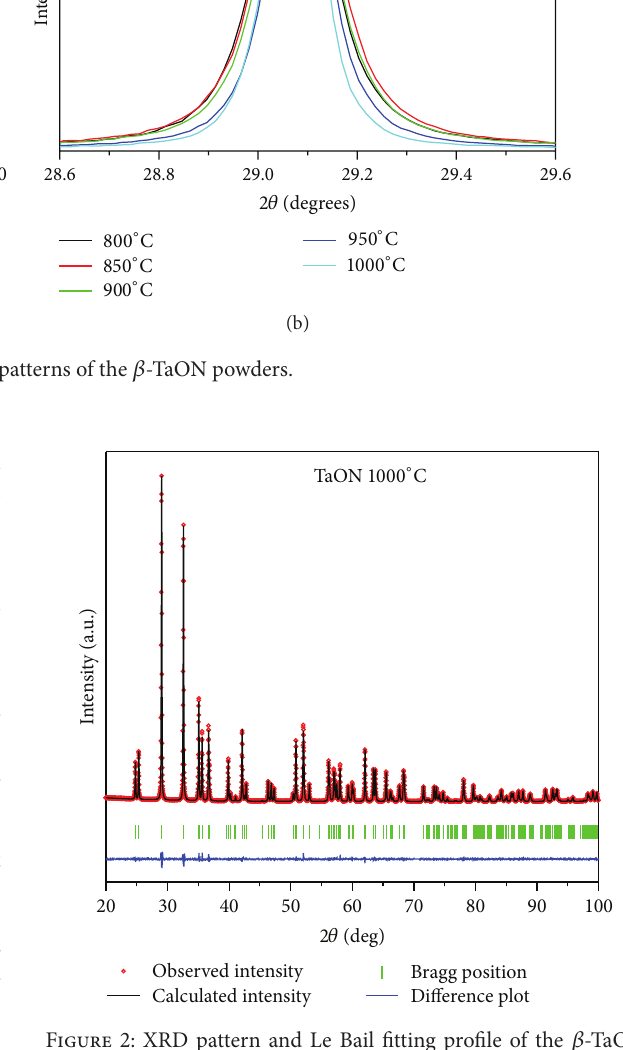
Figure 2: XRD pattern and Le Bail fitting profile of the 𝛽 -TaON powder synthesized at 1000 ∘ C. The difference plot of the observed and calculated diffraction profile is shown together with the Bragg positions represented by short vertical